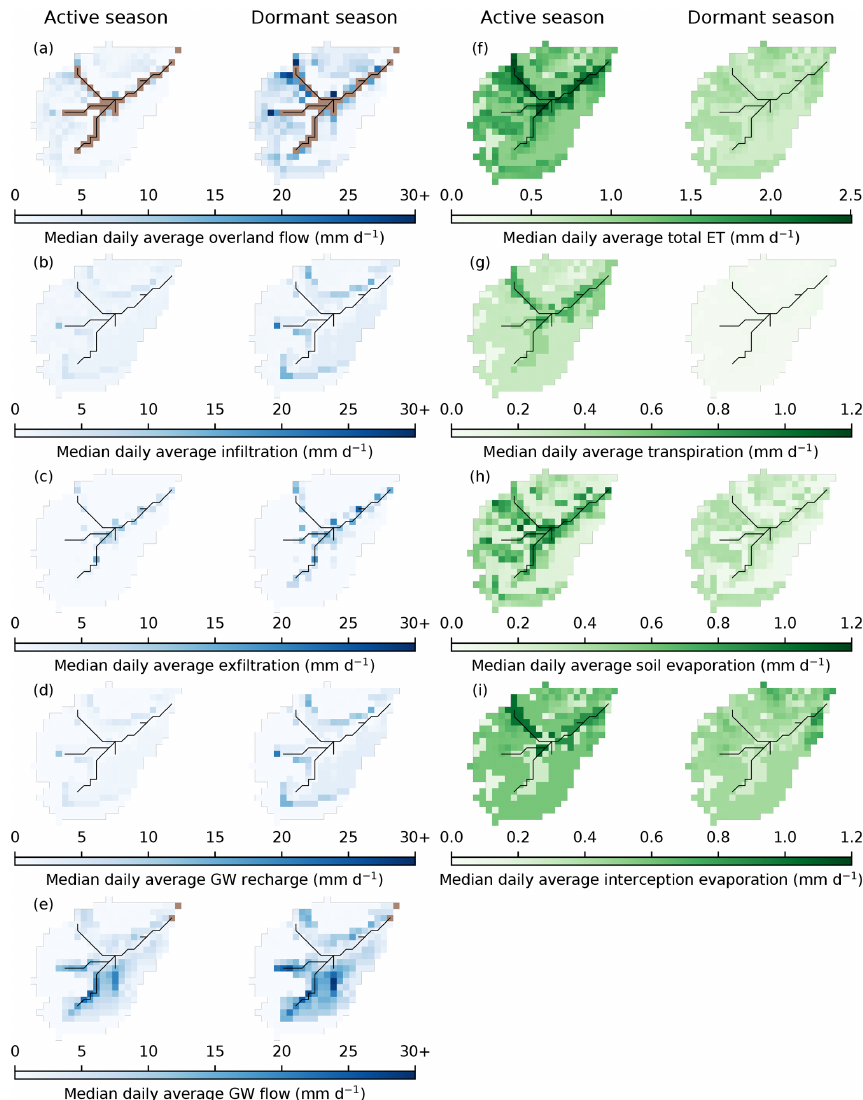
Figure 6. Maps showing median daily average fluxes of the baseline scenario for the active (April to September) and dormant (October to March) seasons. (a) Cell-to-cell overland flow. (b) Infiltration into the first soil layer (L1). (c) Exfiltration to the surface. (d) Groundwater (GW) recharge. (e) Cell-to-cell lateral GW flow. (f) Total evapotranspiration (ET). (g) Transpiration. (h) Soil evaporation. (i) Interception evaporation. Brown cells in panels (a) and (e) are cells for which EcH 2 O-iso does not simulate cell-to-cell overland (channel and outlet cells) and lateral GW flows (outlet cells). Colour bar for blue fluxes is truncated at upper limit to aid in the presentation of spatial patterns (largest flux is 38.9mmd − 1 for overland flow). Note that total ET is on a different scale to the other green